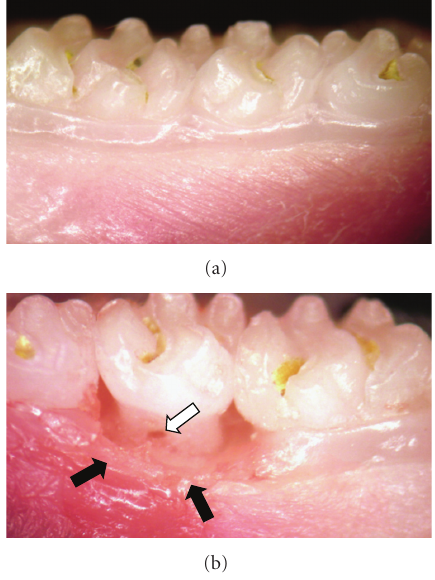
Figure 1: Photographs from healthy (a) and periodontal-diseased teeth (b). (a) Nonligated teeth do not show signs of inflammation. The periodontal supporting tissues present a healthy macroscopic aspect. Some left residues remained on the surface of the normal tooth. (b) Macroscopic signs of inflammation could be observed next to the second left molar of periodontal-diseased rats, after 11 days of ligation. Signs include redness, swelling, and destruction of the normal gingivomucosal tissue around the a ff ected tooth (dark arrows), as well as a furcation lesion (white arrow). Original magnification: 15X.